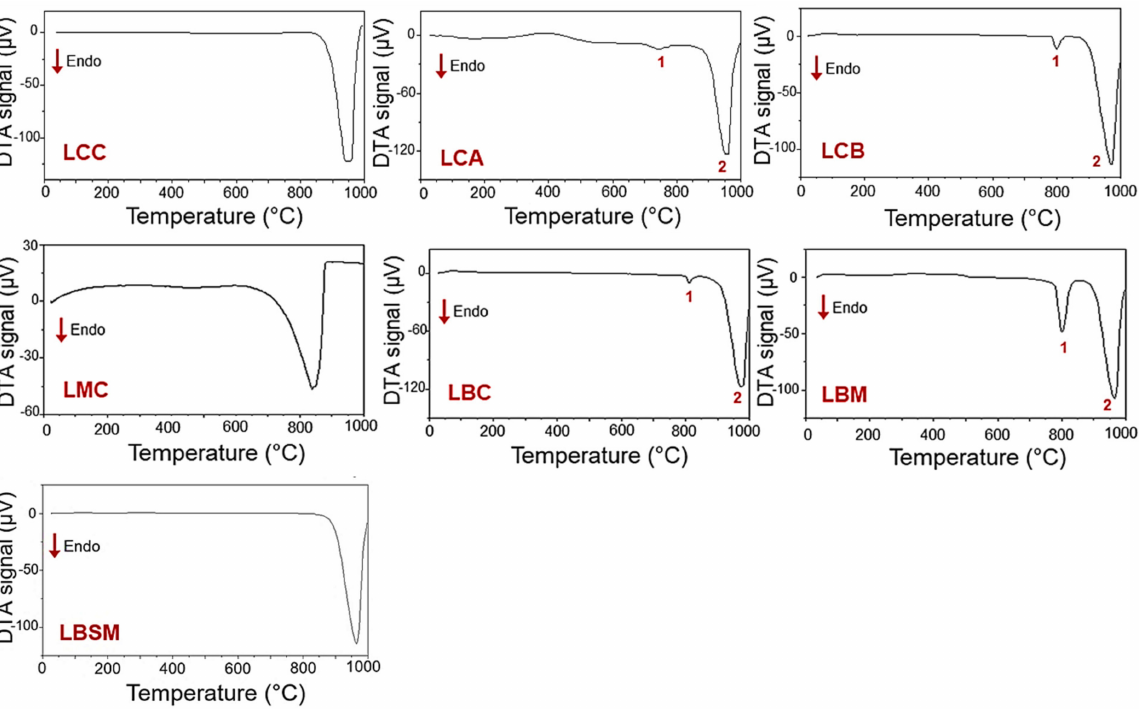
Figure 2. Differential thermal analysis (DTA) curves measured from the limestone samples (LCC, LCA, LCB, LMC, LBC, LBM, and